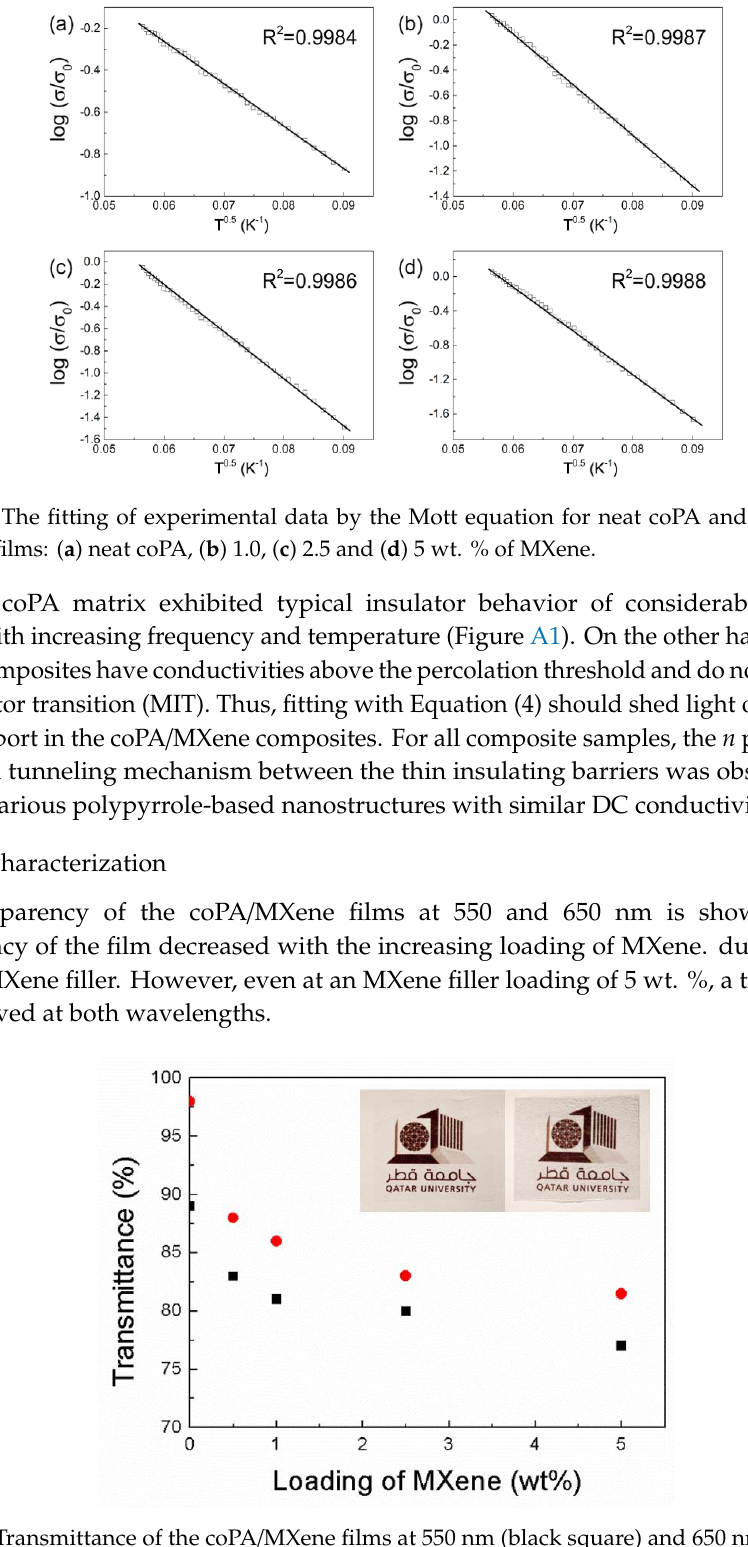
Figure 12. Transmittance of the coPA / MXene films at 550 nm (black square) and 650 nm (red circles) with an inserted picture of the QU logo covered by neat coPA ( left ) and coPA filled with 5 wt. % of MXene ( right ). The thickness of both films is approximately 150 µm.